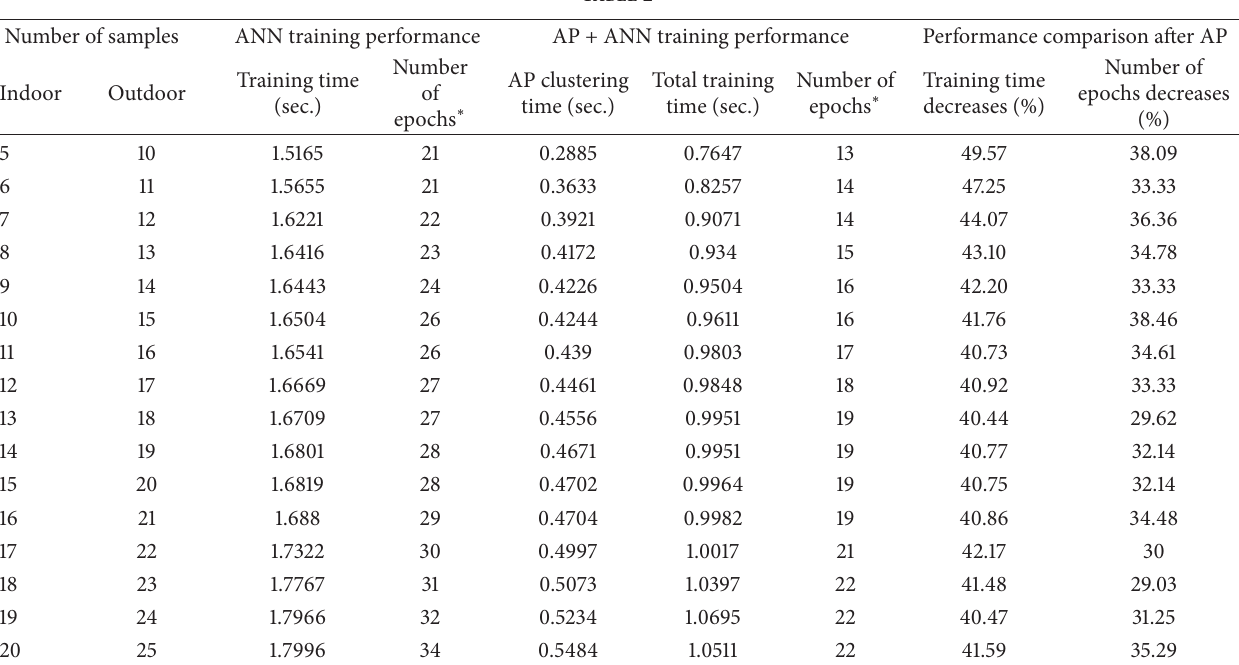
∗ The fraction values of the epochs are expressed by the nearest integer